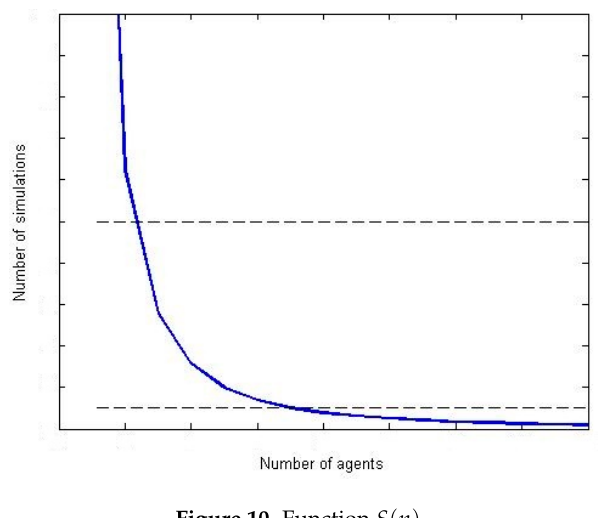
Figure 10. Function S ( n )